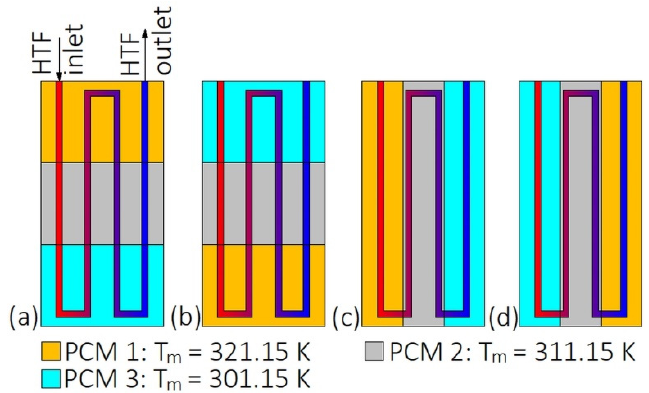
Figure 1. Heat exchanger with multiples phase change materials (PCMs) [46]: ( a ) Horizontal descending arrangement; ( b ) horizontal descending arrangement; ( c ) vertical descending arrangement; ( d ) vertical ascending arrangement. T m —melting temperature.